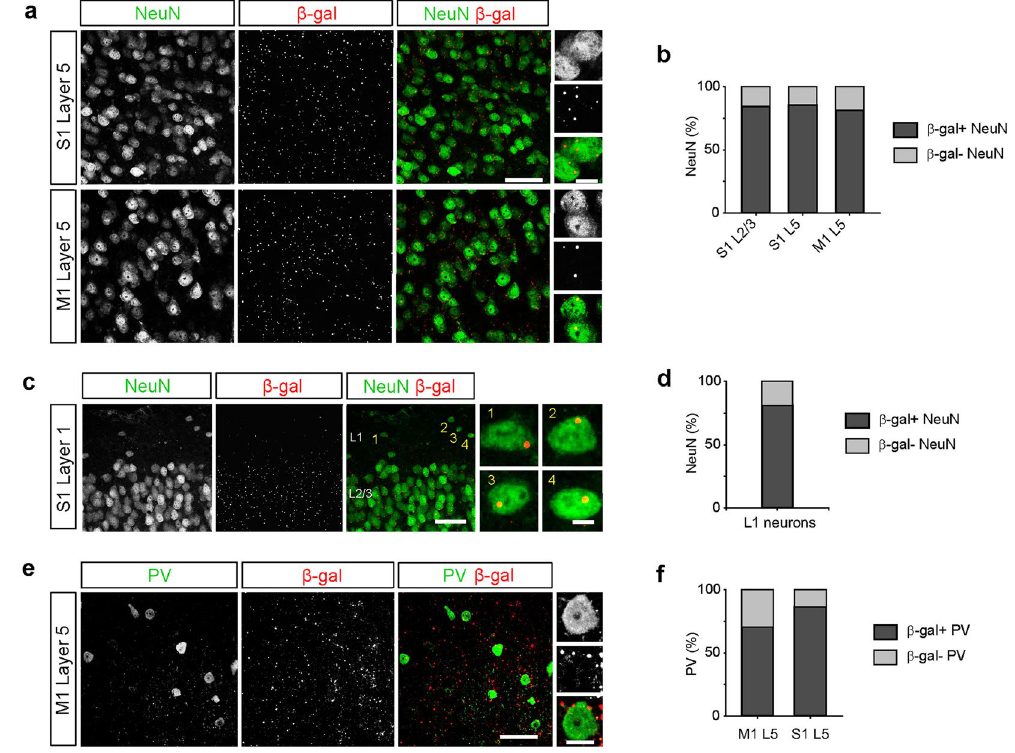
Figure 2. C9orf72 promoter activity is widespread in inhibitory neurons. ( a ) Representative images of layer 5 (L5) of primary somatosensory cortex (S1, top ) and primary motor cortex (M1, bottom ) from C9orf72 LacZ/ + mice stained for NeuN (green) and β -galactosidase ( β -gal; red). High magnification images show β -gal-positive puncta within NeuN-positive neurons ( rightmost panels ). Scale bars: 50 μ m and 10 μ m. ( b ) The percentage of neurons containing β -gal puncta in layer 2/3 and L5 of somatosensory cortex and L5 of motor cortex (S1 L2/3: 362 of 429 cells, 84.4%; S1 L5, 499 of 583 cells, 85.6%; M1 L5: 425 of 523 cells, 81.3%; n = 3 mice for each group, p = 0.1378, Chi-Square test). ( c ) Representative images of layer 1 (L1) of somatosensory cortex stained for NeuN (green) and β -gal (red). High magnification images showing β -gal-positive puncta within L1 neurons ( rightmost panels ). Scale bars: 50 μ m and 5 μ m. ( d ) The percentage of L1 neurons containing β -gal puncta (26 of 32 cells, 81.3%, n = 3 mice). ( e ) Representative images of L5 of motor cortex stained for parvalbumin (PV, green) and β -gal (red). High magnification images show β -gal puncta within a PV interneuron ( rightmost panels ). Scale bars: 50 μ m and 10 μ m. ( f ) The percentage of PV interneurons containing β -gal puncta in L5 of motor cortex and somatosensory cortex (M1 L5: 36 of 51 cells, 70.6%; S1 L5: 32 of 37 cells, 86.5%; n = 3 mice for each group, p = 0.0789, Chi-Square